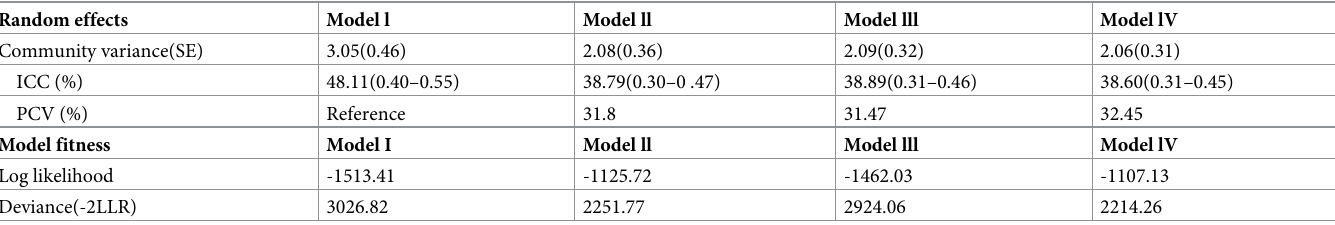
Table 3. Random effects and model